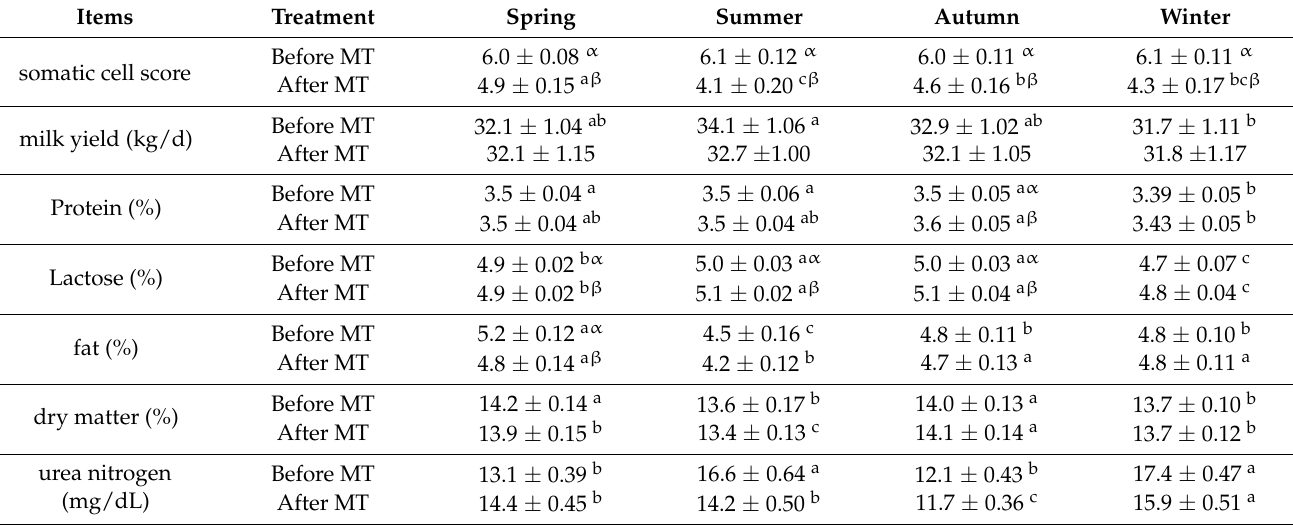
Table 3. Effects of the treatment with melatonin on the DHI in cows with high somatic cell scores (SCS) during different seasons.